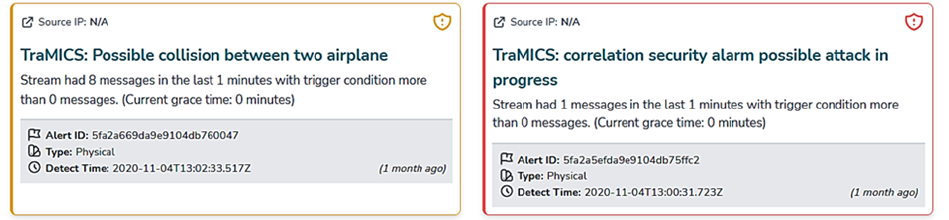
Figure 16. Watch List Alert Cards example (see [49] for more information on TraMICS). When the user clicks on a specific Alert Card, the corresponding Alert details will be displayed. Details include the Alert title and description, information identifying the Alert, the source and target details, and the probability of this Alert being an Incident. If the card is a specific Incident Card, the corresponding Incident details as well as the related Alerts will be displayed (Figure